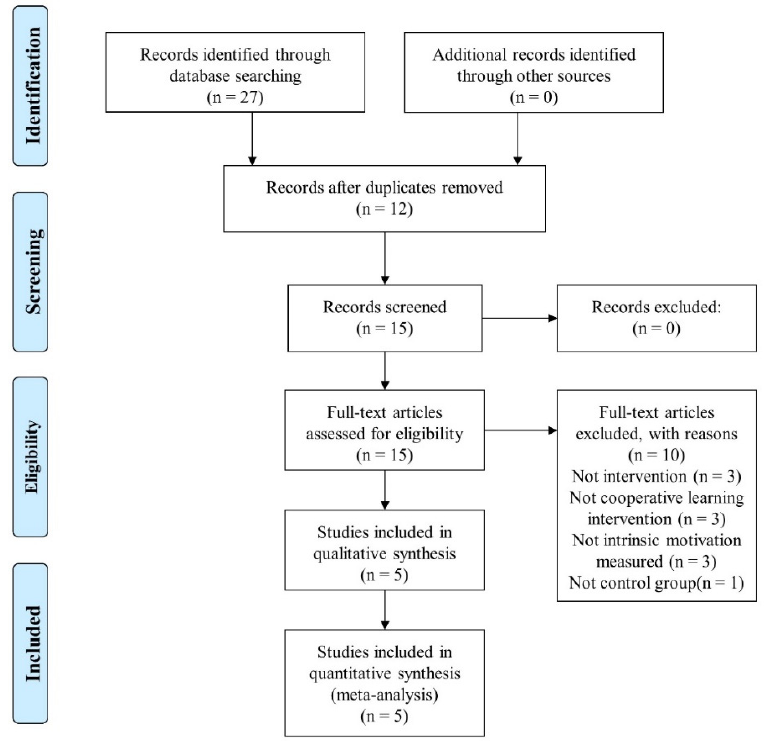
Figure 1. Flow diagram for the systematic review process according with PRISMA statements.